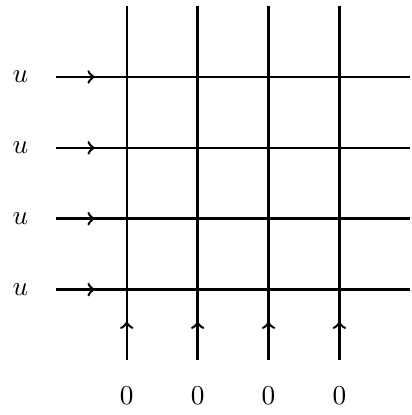
Figure 2 . The spectral parameters on the lattice of the six-vertex